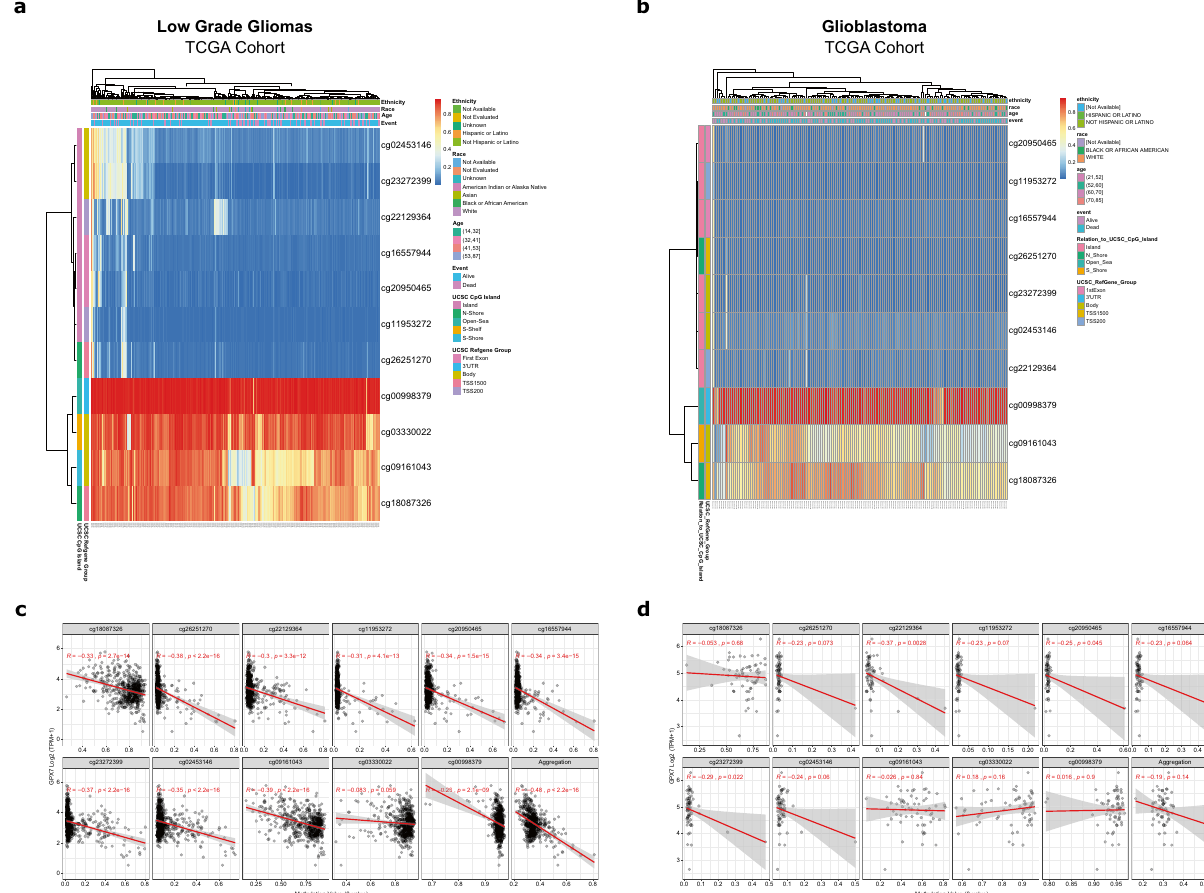
Figure 5. Dynamics of the DNA methylation across CpG sites of GPX7 in LGG and GBM tumors . ( a ) Heat- map showing the methylation levels of GPX7 among different CpGs sites (probes) integrating ethnicity, race, age, vital status and genomic regions of CpG sites from LGG; ( b ) Heat-map showing the methylation levels of GPX7 among different CpGs sites integrating ethnicity, race, age, vital status and genomic regions of CpG sites from GBM. ( c ) Pearson correlation between the degree of methylation (β-value) of each CpG site of GPX7 and its expression level (Log2 – TPM + 1) in LGG; Aggregation method: mean; ( d ) Pearson correlation between the degree of methylation (β-value) of each CpG site of GPX7 and its expression level (Log2 – TPM + 1) in GBM. Aggregation method: